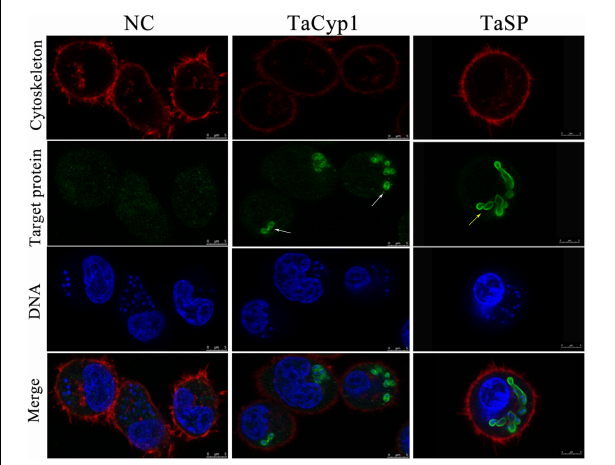
FIGURE 3 | Sub-cellular localization of target proteins. NC stained with negative serum was no green fluorescence, and TaSP was observed with green fluorescence on membrane of T. annulata shizonts as positive control (yellow arrow). TaCyp1 was mainly distributed around membrane of T. annulata shizonts (white arrow). Cell cytoskeleton stained with Alexa Fluor TM 594 Phalloidin and DNA stained with Hoechst 33342 were observed with red fluorescence and blue fluorescence, respectively, and target proteins stained with purified sera and Alexa Fluor 488 were observed with green fluorescence. The merge were fused images under the above three